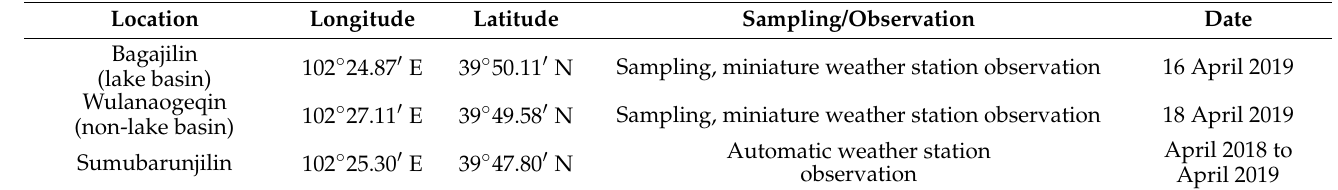
Figure 3. Photos of fieldwork and observation stations. ( a ) Environment of the lake basin (Bagajilin). ( b ) Environment of the non-lake basin (Wulanaogeqin). ( c ) Sampling profile with a depth of 30 cm. ( d ) In-situ weighing. ( e ) Miniature weather station in the lake basin. ( f ) Automatic weather station in Sumubarunjilin. Table 1. Basic description of the field work.